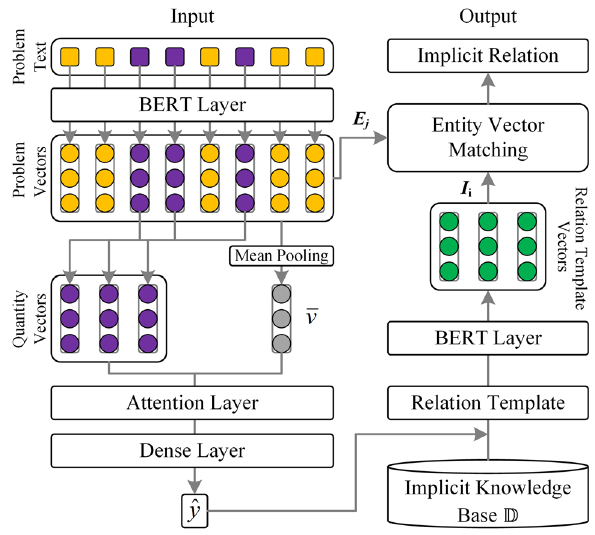
Fig. 4 The architecture of the main part of Procedure